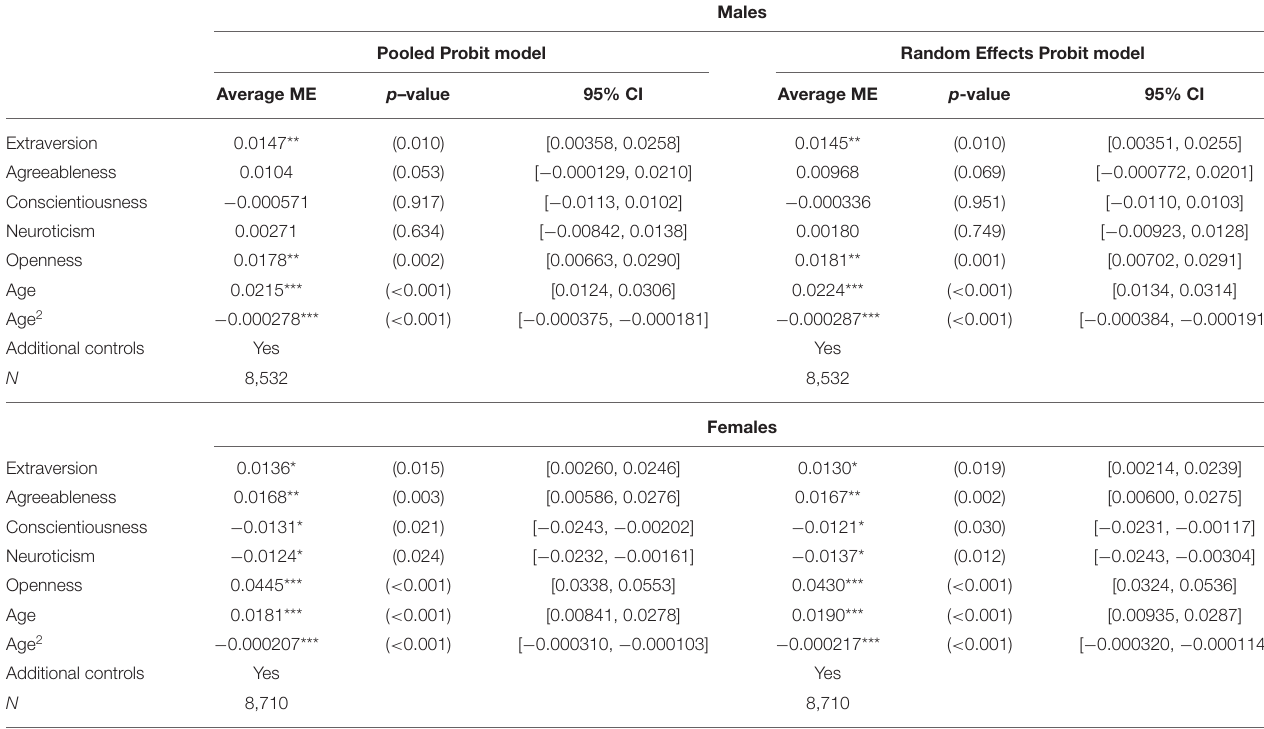
TABLE 8 | Big Five Personality Dimensions and participation in non–formal training by